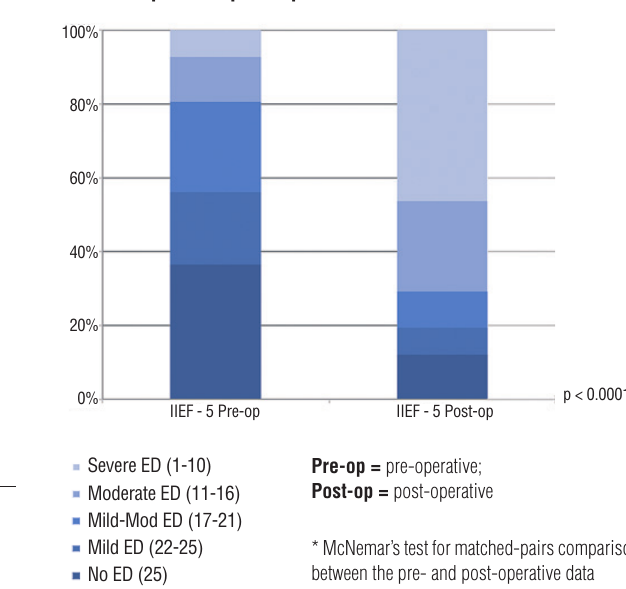
Figure 1 - self-assessment of erectile function - comparison between pre and